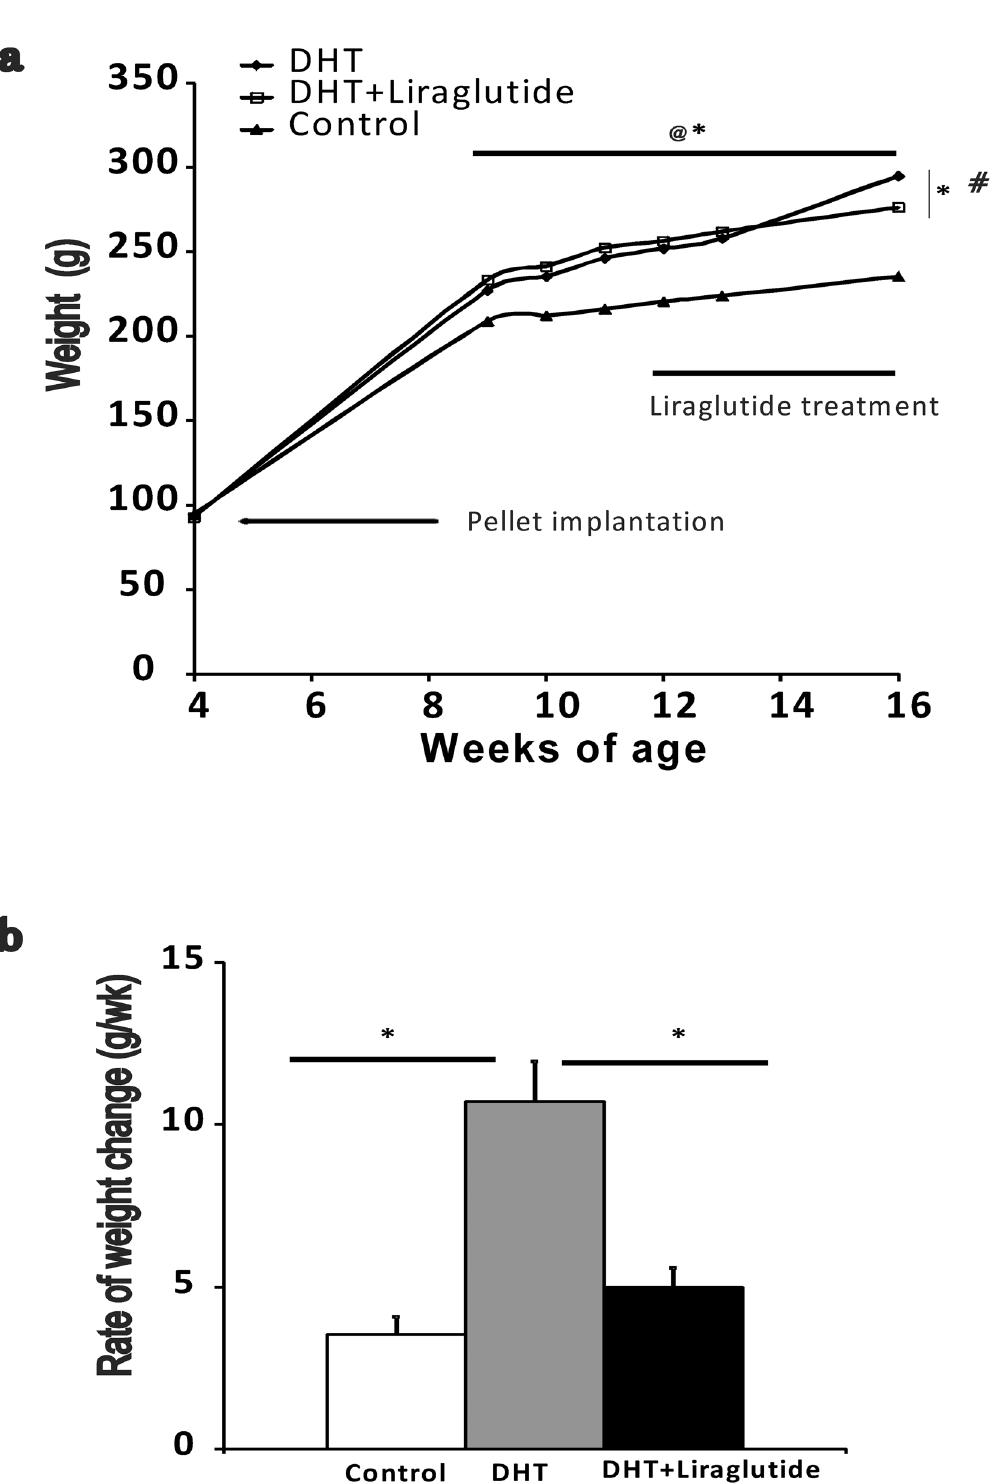
Fig 2. Effect of liraglutide on DHT induced weight gain. (Mean ± SEM; g): a) Rats were weighed at 4 weeks and again from 9 – 13 weeks and at 16 week. “ # ” denotes p < 0.05 between DHT and DHT+liraglutide and “ @ ” denotes p < 0.05 between DHT and control. b) Rate of weight change per week between 12 – 16 weeks. n = 12 rats in DHT and DHT+ liraglutide group n = 9 control group. * denotes p < 0.05 between DHT +liraglutide and DHT and control.